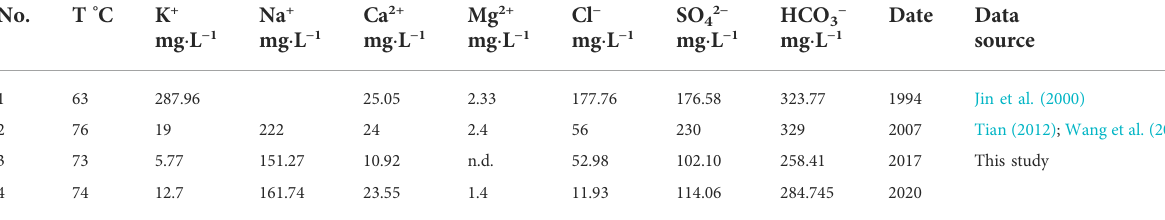
TABLE 1 Hydrochemistry characteristics of the Hongshuilantang Hot Spring in Jiaodong Peninsula. No.